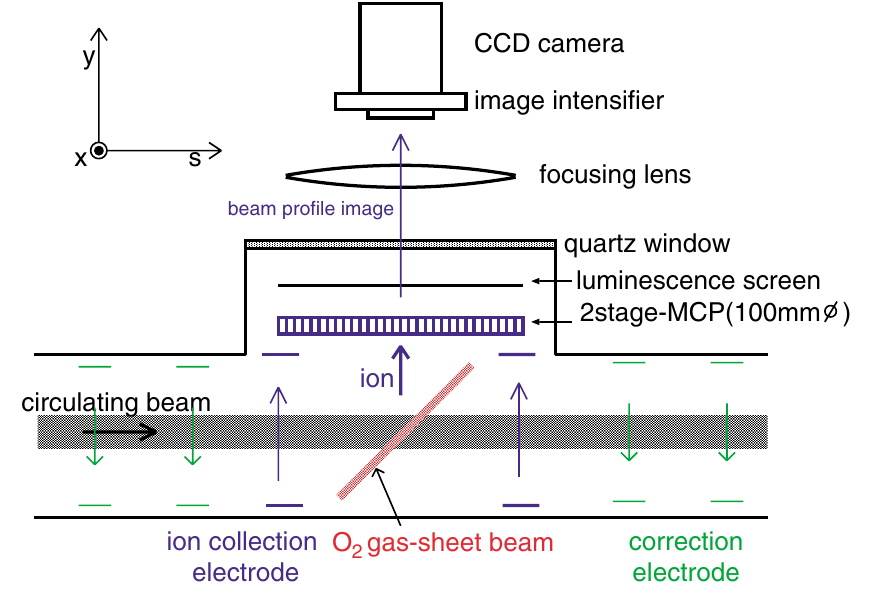
FIG. 1. (Color) Layout of the gas-sheet beam-profile